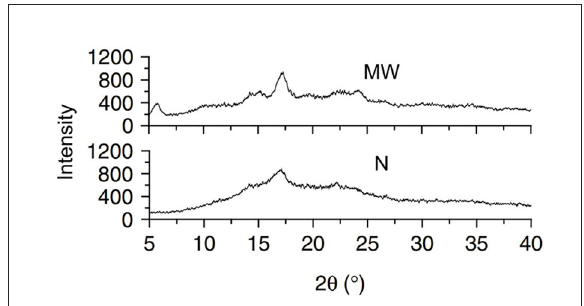
FIGURE3 X-ray diffraction (XRD) of Indian horse chestnut starch granules. N, native; MW, microwaved